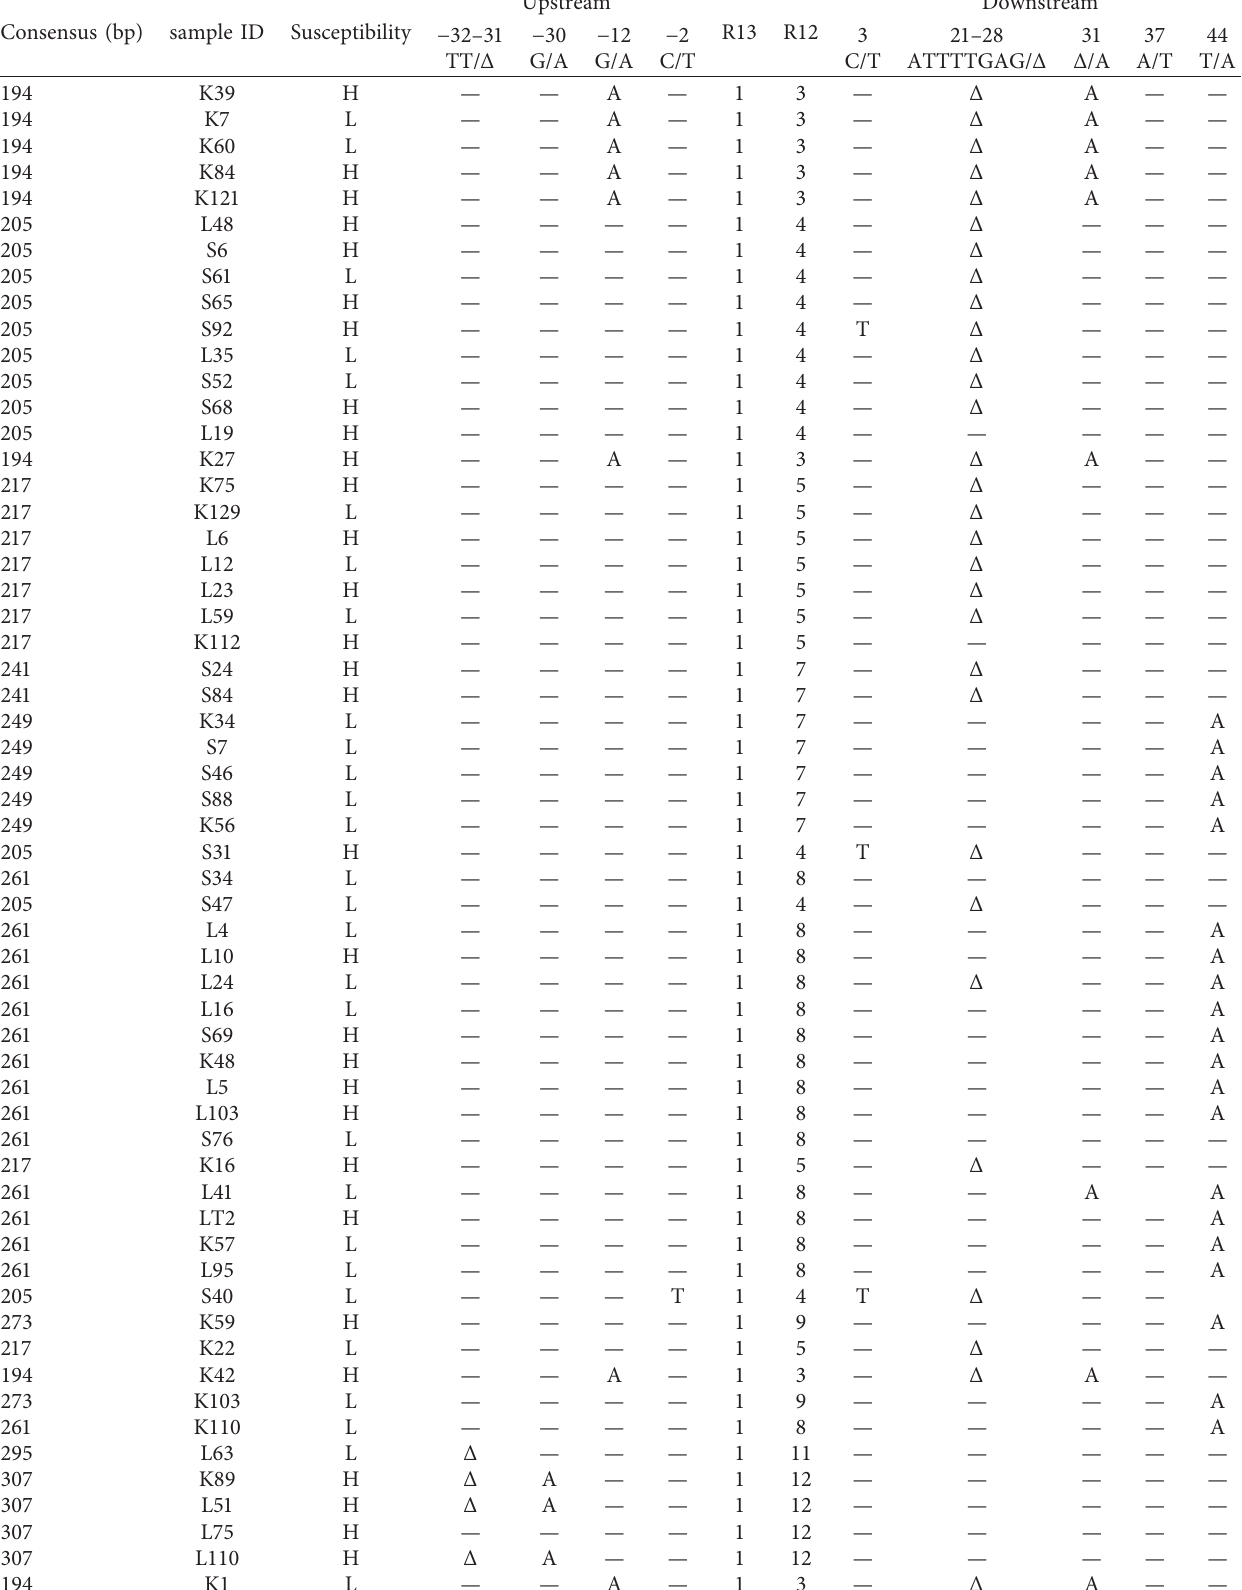
Table 1: Polymorphisms identified from LEI0258